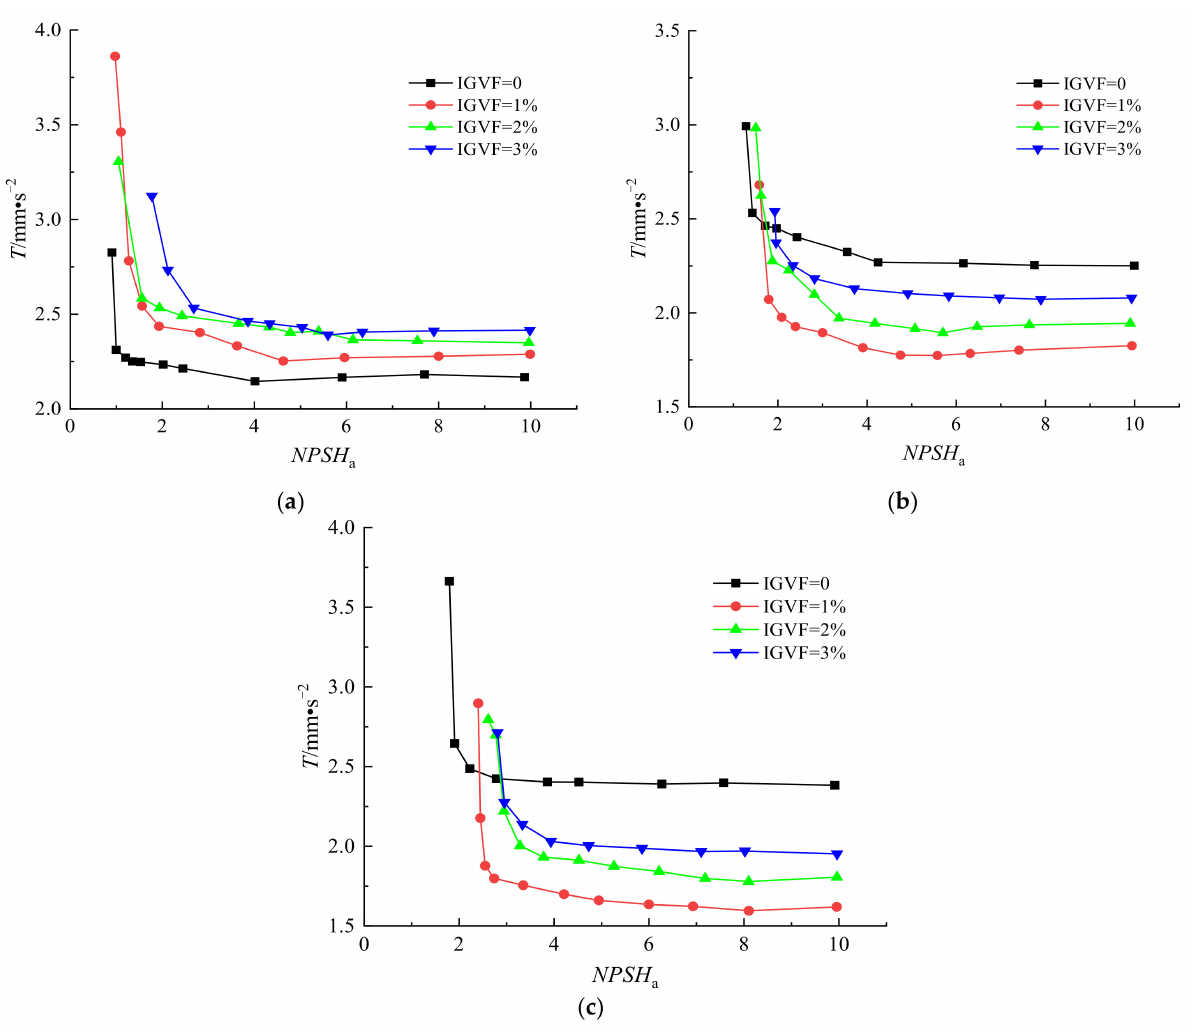
Figure 7. Vibration intensity of the model pump inlet under different IGVF conditions and different